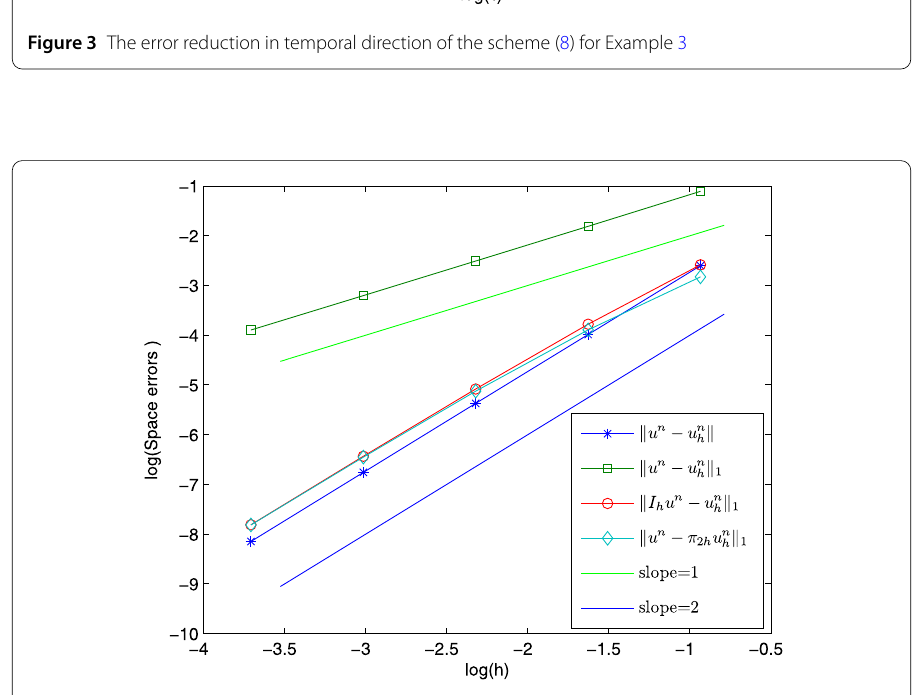
Figure 4 The error reduction in spatial direction of the scheme (8) for Example 3 with α =